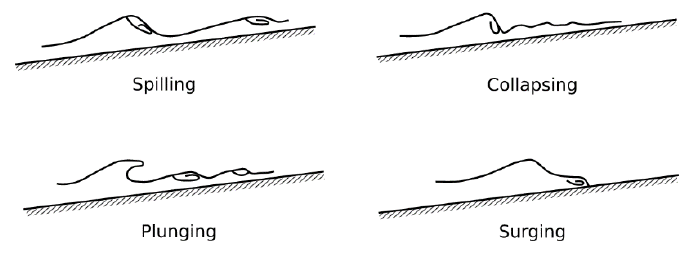
Figure 7. Breaking wave types [41].